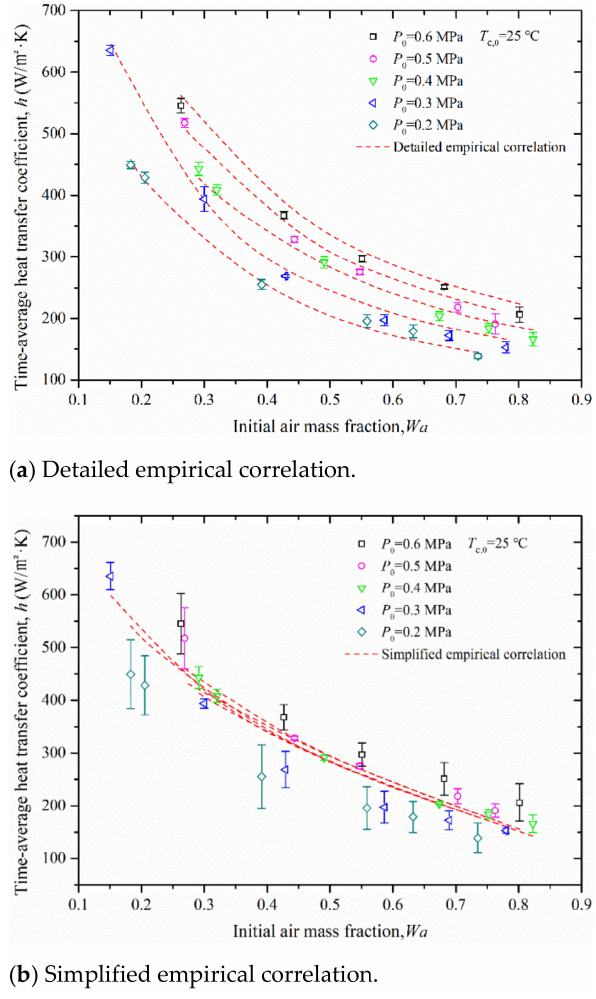
Figure 5. Predicted values of empirical correlation under different gas-mixture pressure.